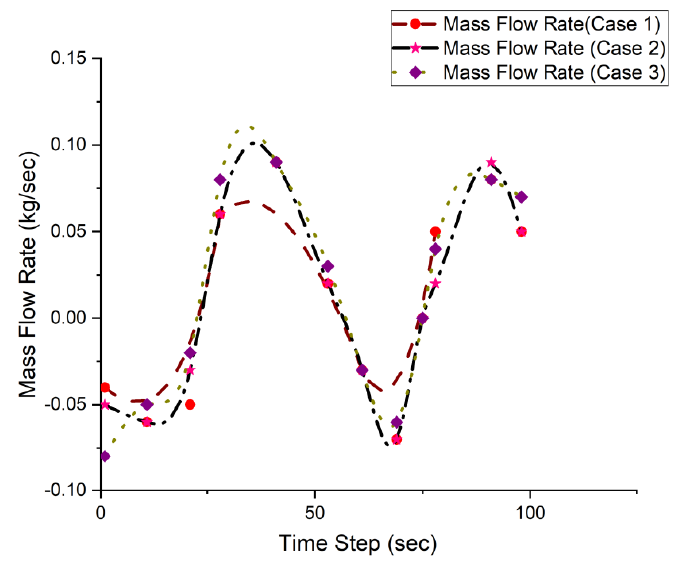
Figure 6. E ff ect of mass flow rates through pulse tube cross section for cases Figure 6. Effect of mass flow rates through pulse tube cross section for cases 1–3.